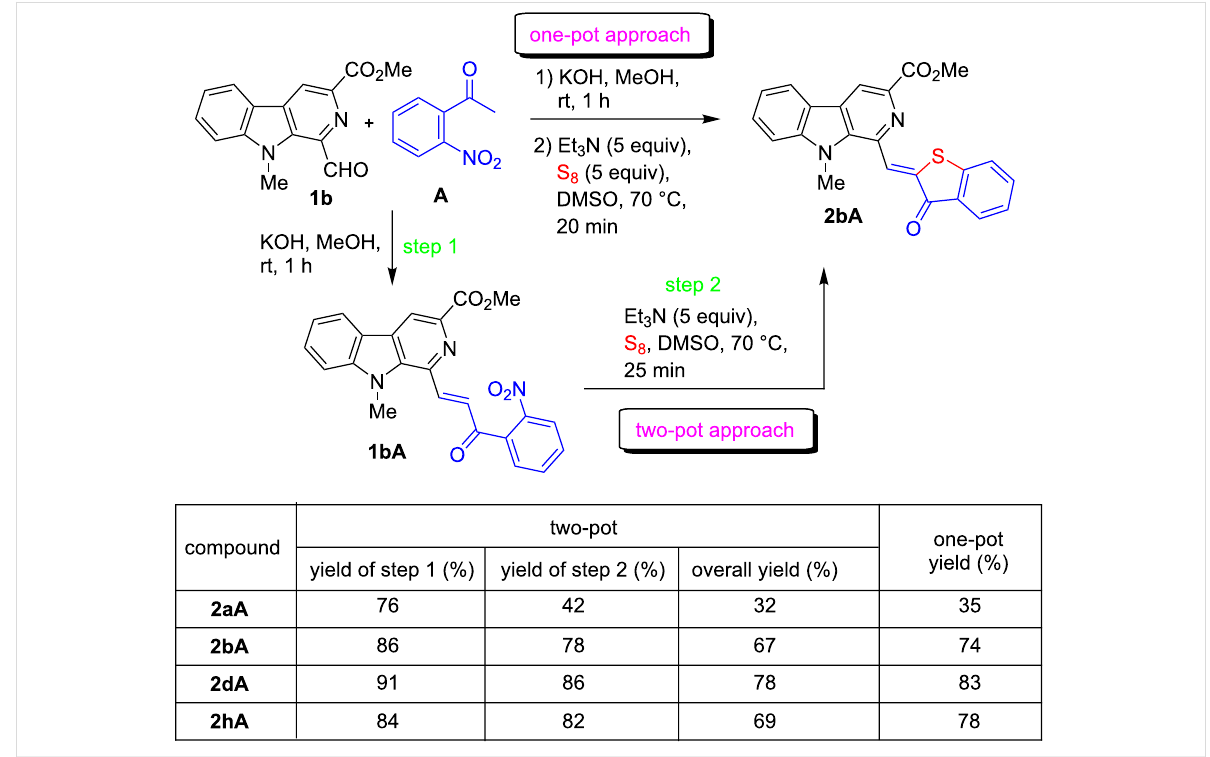
Scheme 3: Comparison of outcome of one-pot vs two-pot